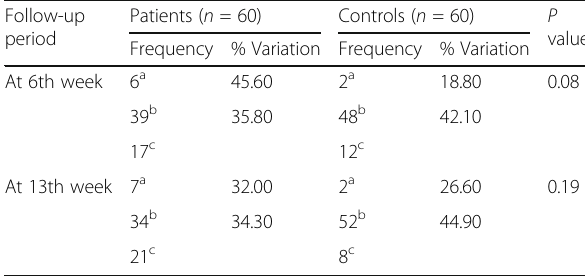
n number of participants. a Decrease. b Increase. c Same